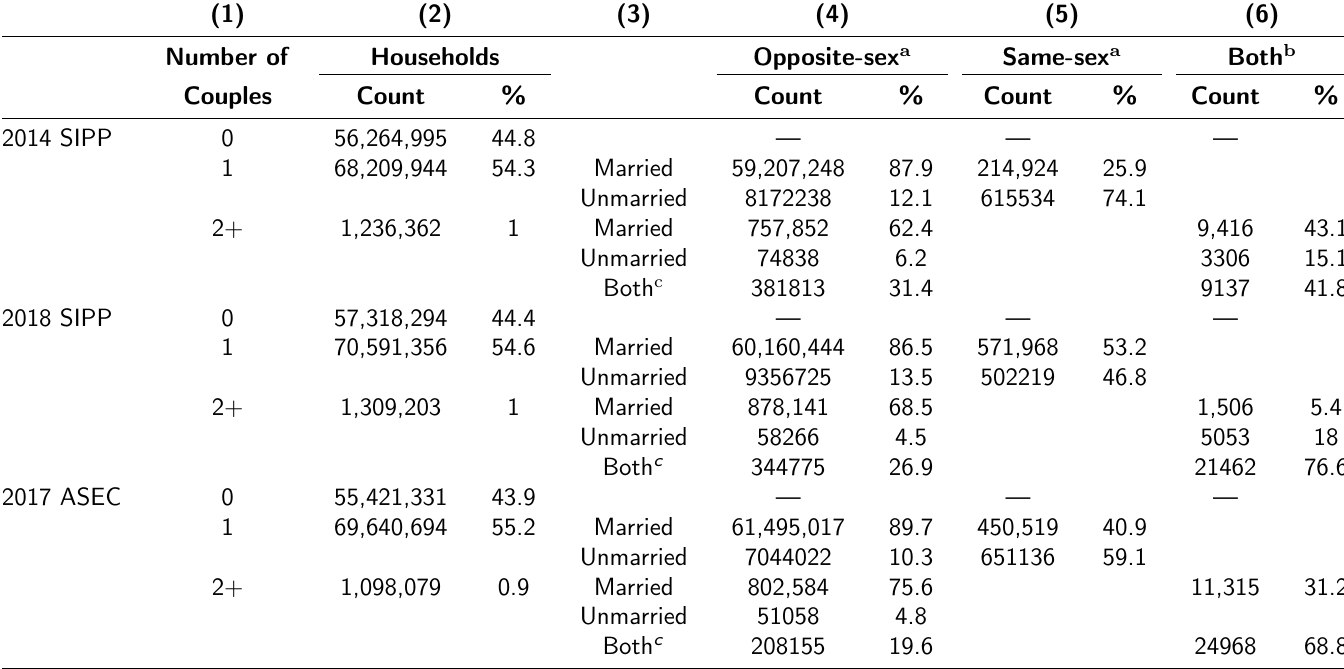
Table 1: Estimated counts of households by number of couples and couple